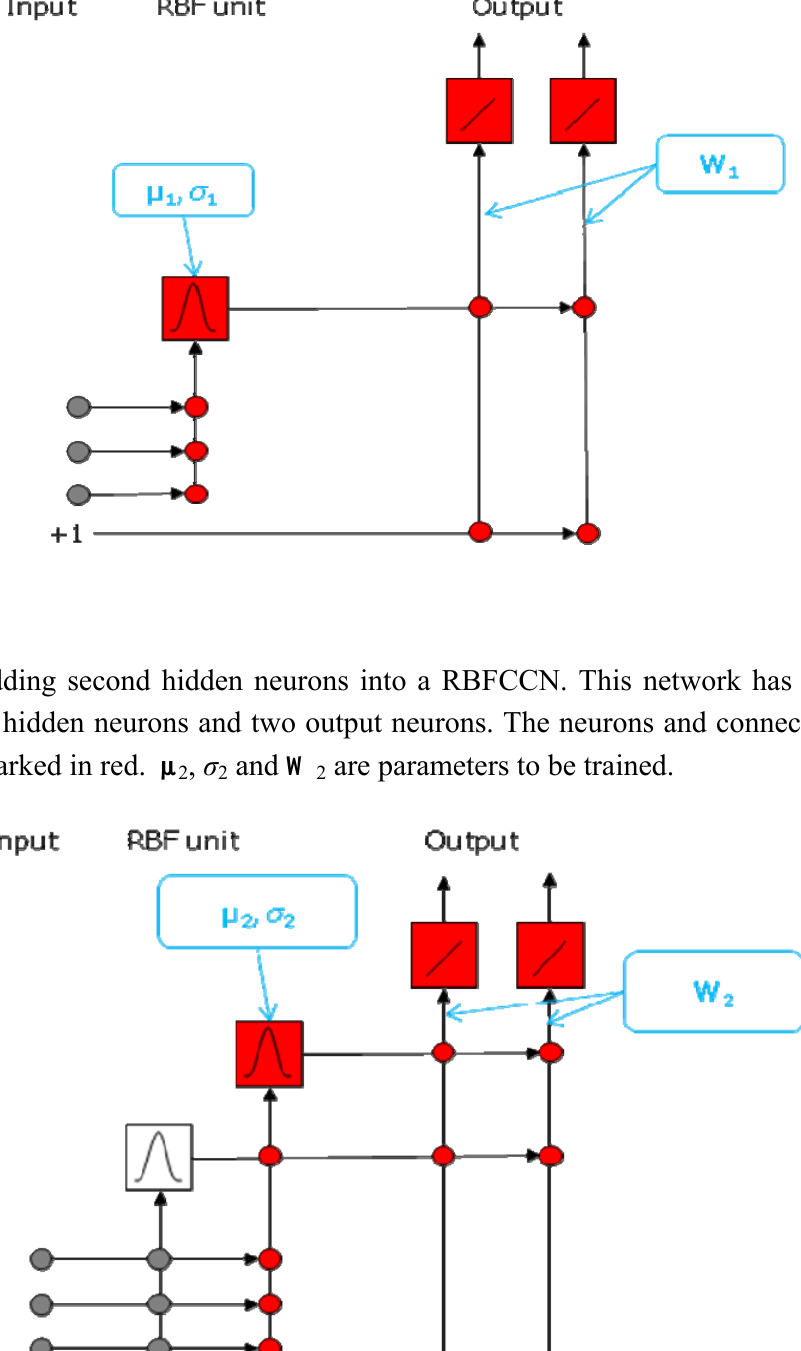
Figure 4. Adding first hidden neurons into a RBFCCN. This network has three input neurons, one hidden neuron and two output neurons. The neurons and connections being trained are marked in red. µ , σ and W are parameters to be trained. 1 1 1